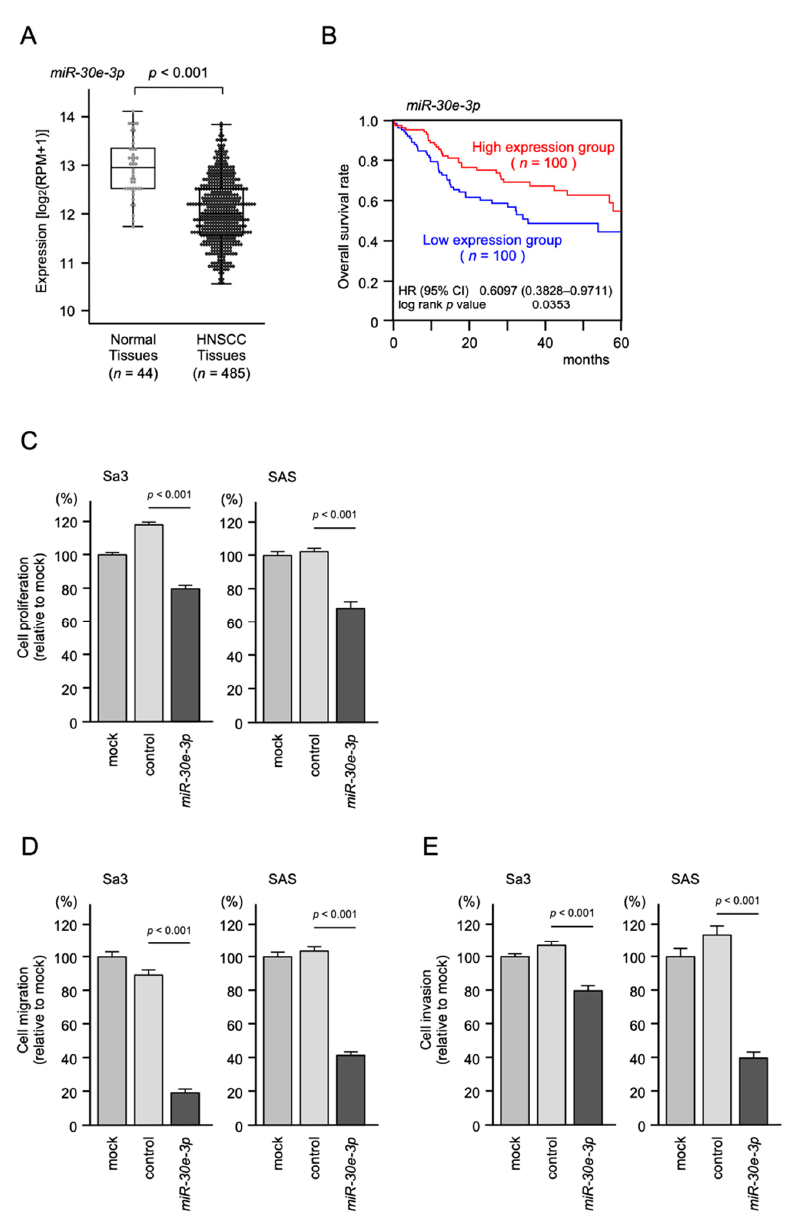
using TCGA-HNSC data. Patients with low expression of miR-30e-3p had a significantly poorer prognosis compared to those with high expression [log lank p value = 0.0353, hazard ratio (HR) = 0.6097, 95% confidence interval (95% CI): 0.3828–0.9711] (Figure 1B).